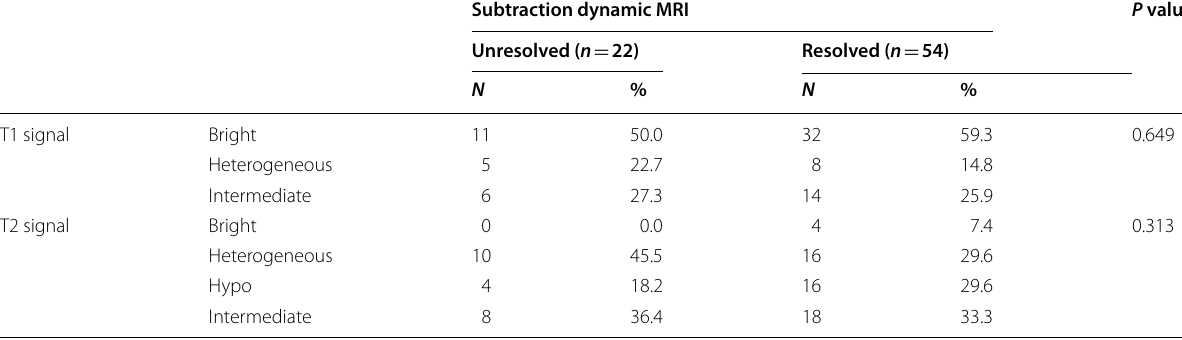
Table 3 Frequency distribution of T1 and T2 signals in unresolved and resolved lesions based on subtraction MRI findings